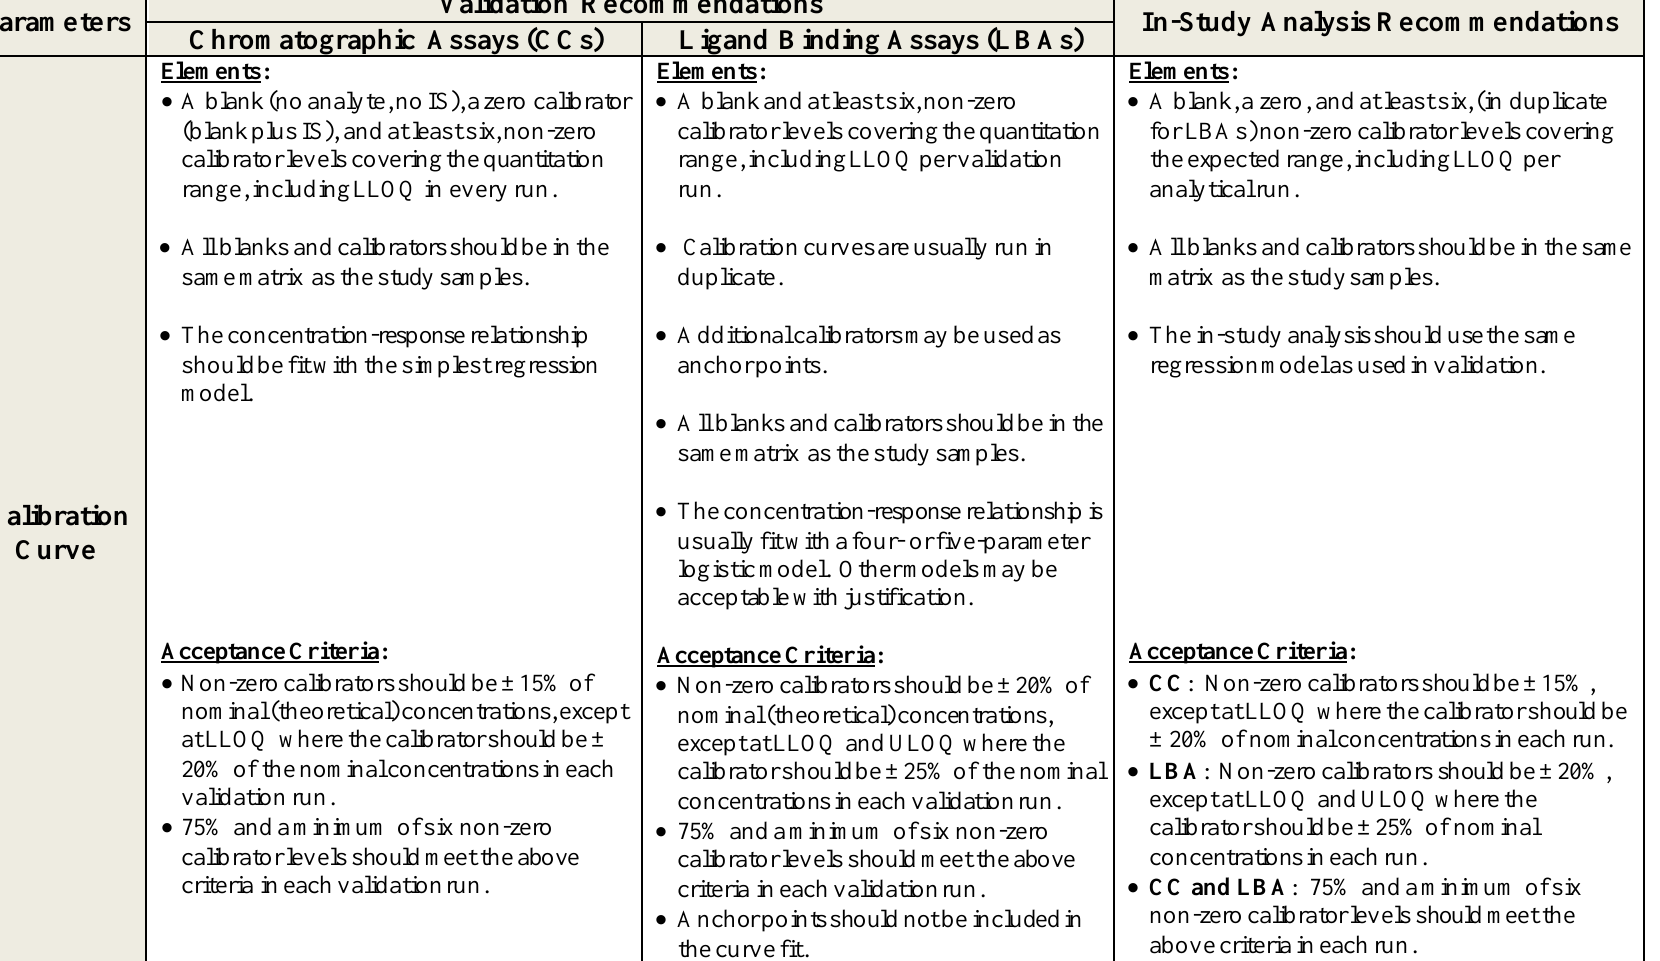
Table 1. Recommendations and Acceptance Criteria for Bioanalytical Method Validation and In-Study Conduct (refer to sections III.A and III.B for additional